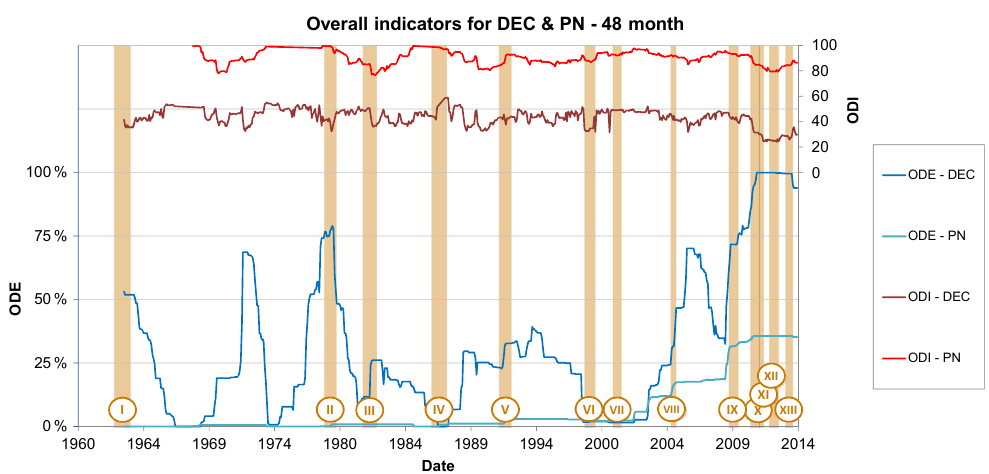
Figure A12. ODE and ODI values using the 48-month timescales of DEC and PN indices, compared with the 13 detected historical droughts (in